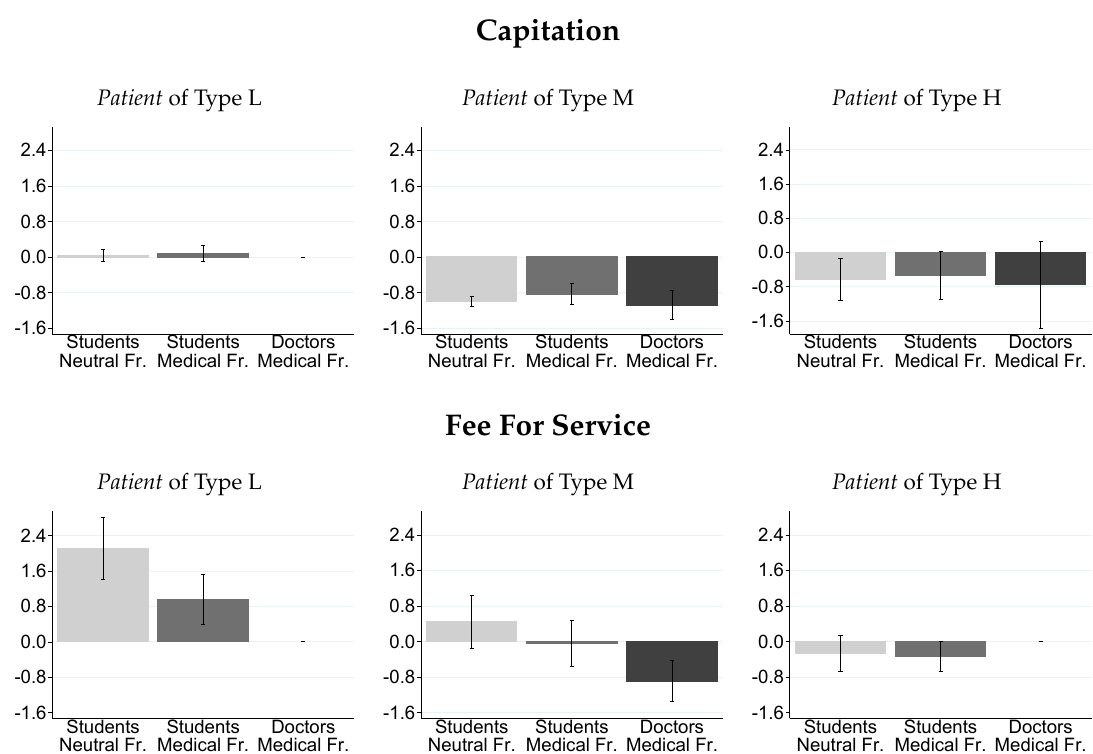
Figure 2. Average deviation from optimal treatment across experimental conditions. Notes: This figure illustrates average deviation from optimal treatment and 95% confidence intervals across experimental conditions. The values are standardized such that optimal Medical Service provision is 0; positive (negative) values indicate overprovision (underprovision). Each subject decided on the reporting and provision of (medical) services of every Patient type. Therefore, the total number of observations is